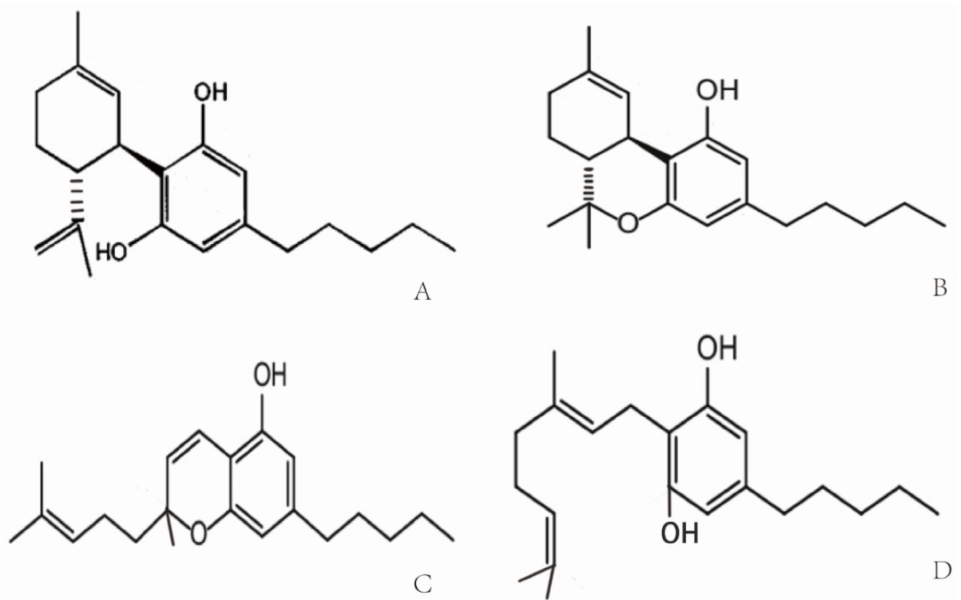
Figure 1. ( A ) Molecular structures of cannabidiol (CBD) [26] ( B ) ∆ 9-tetrahydrocannabinol ( ∆ 9-THC), ( C ) cannabichromene (CBC), and ( D ) cannabigerol (CBG)